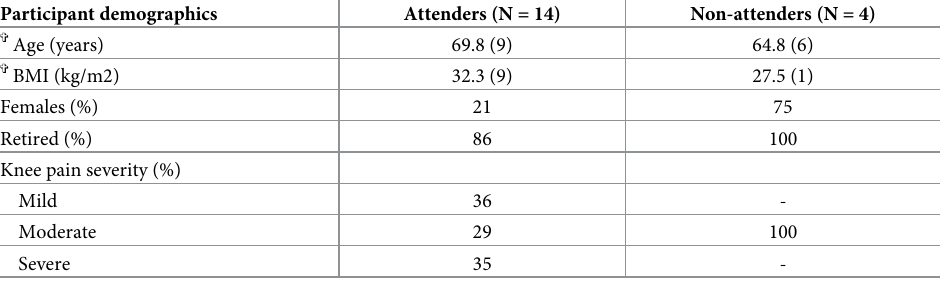
Table 1. Demographic details of participants according to whether they attended or did not attend all treatment visits.